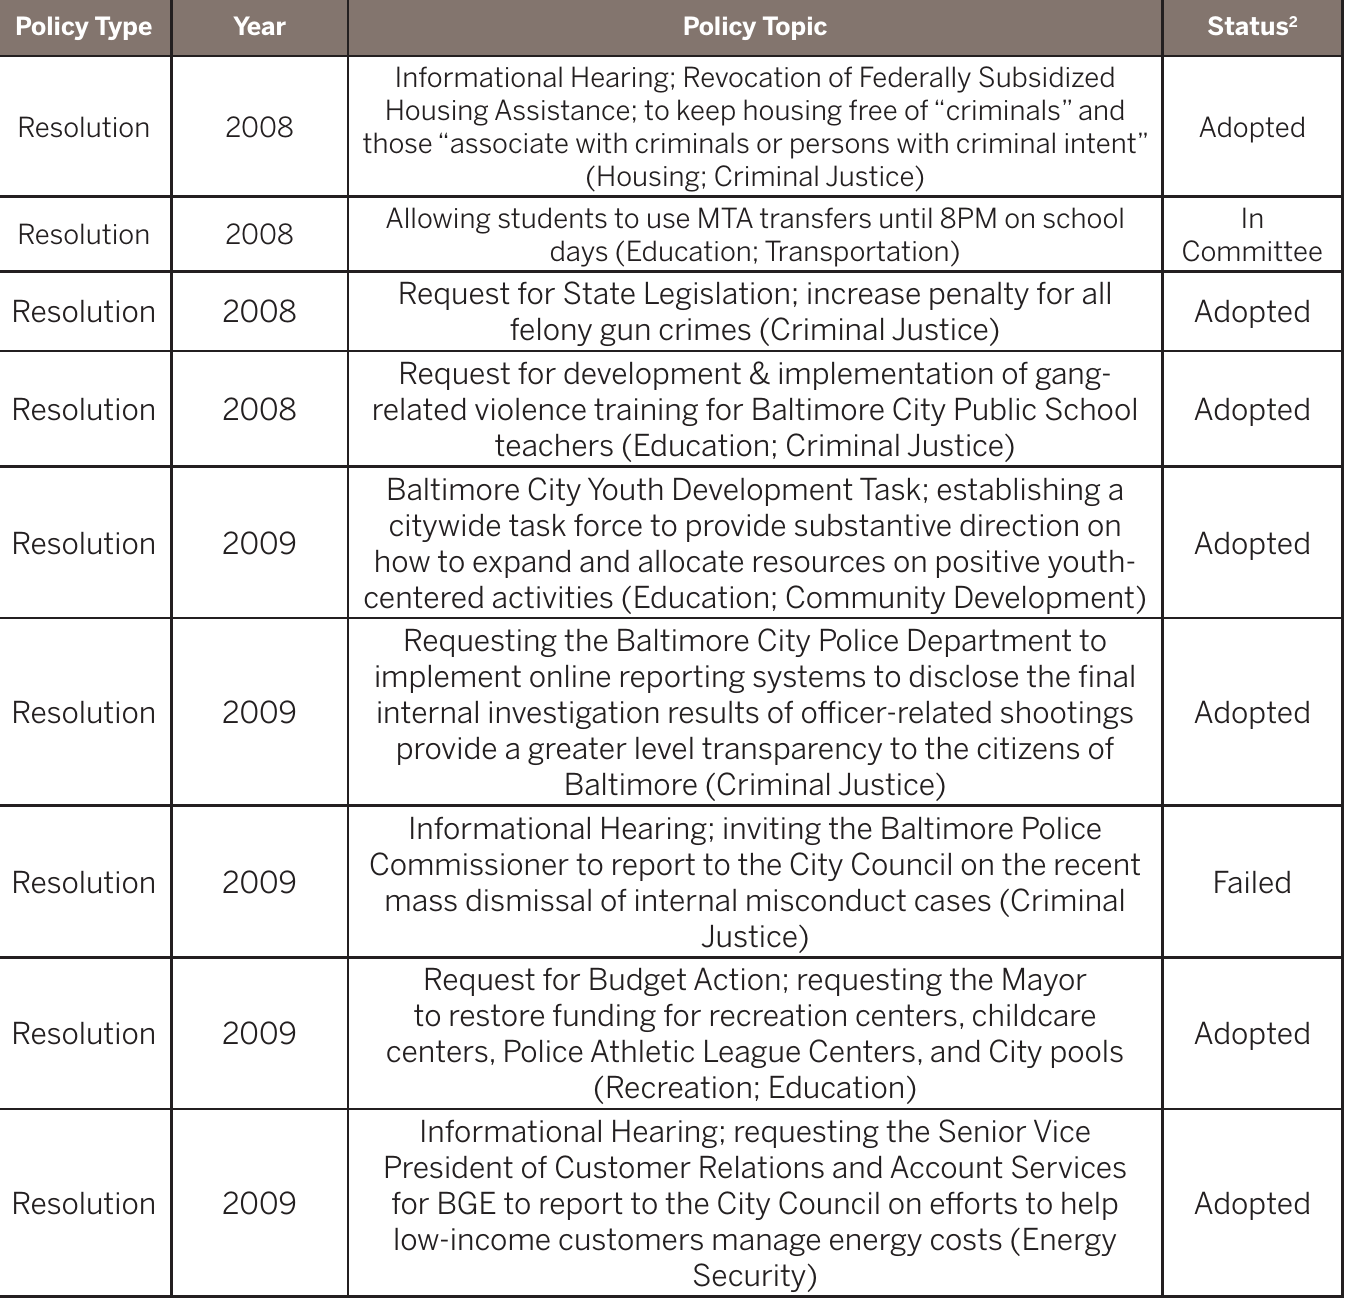
Table 2: Missed Opportunities to Inform Policy Decisions Related to SDH: 25 Illustrative Examples of Place and Health-Impacting Policies Not Reviewed by BCHD Policy